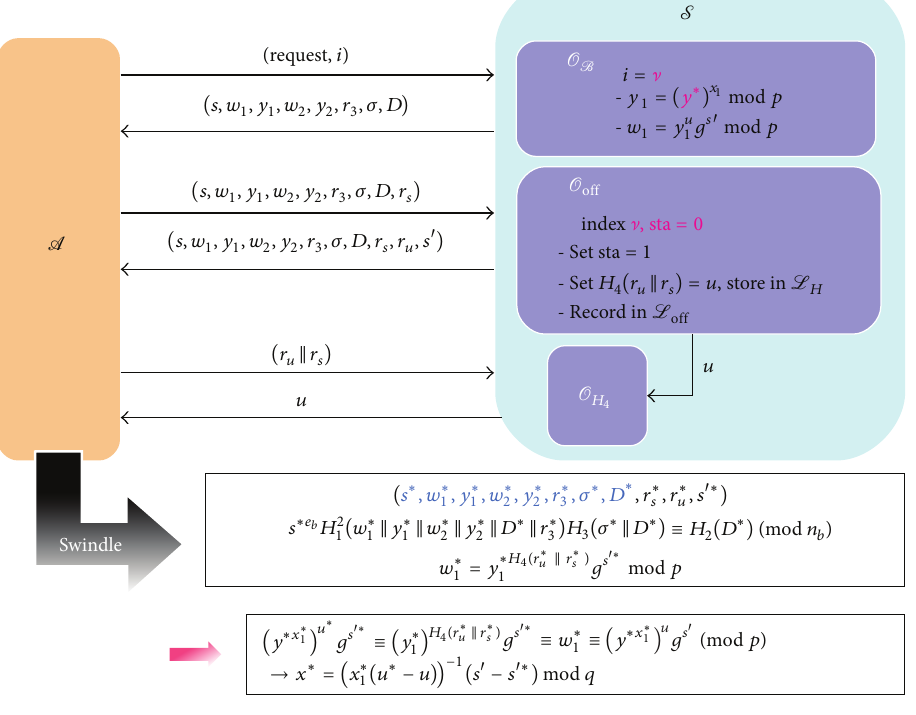
Figure 10: The proof model of